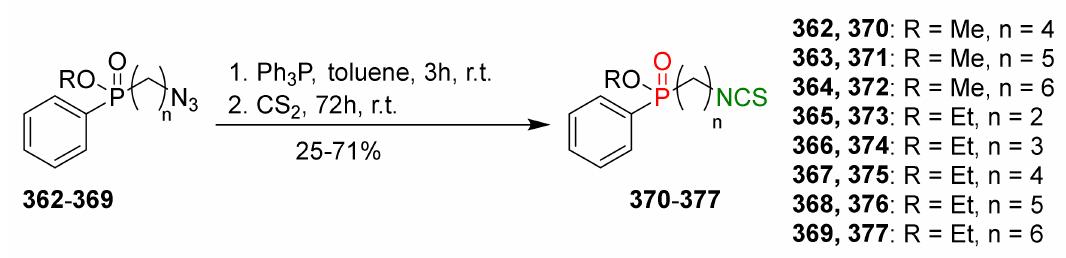
Figure 41. Synthesis of ( ω -isothiocyanatoalkyl)(diethoxymethyl)phosphinates 358 – 361 .